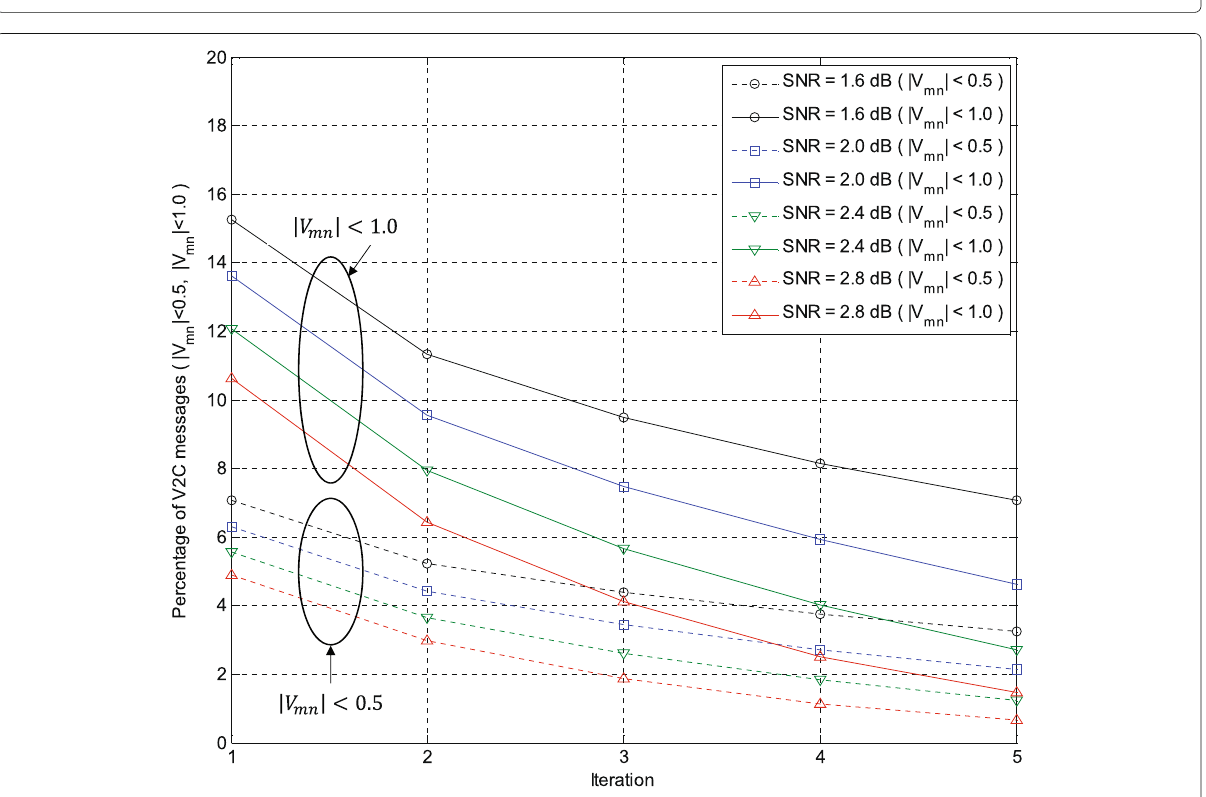
Fig. 14 Normalized check node complexity of the normalized min-sum algorithm, conventional FC scheme, and proposed algorithm (ADZF)